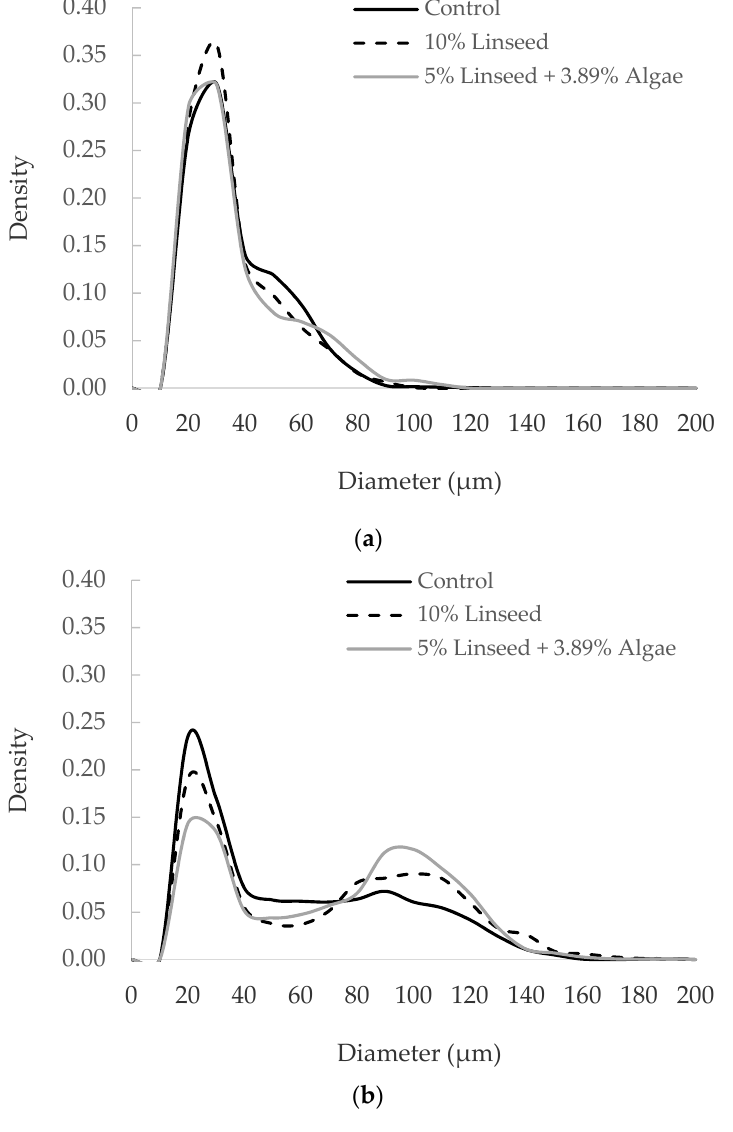
Figure 5. Effect of addition of linseed or linseed and algae to the diet on the adipocyte size distribution of lambs. Data reanalyzed from Urrutia et al. [71] (see Supplementary Material 1–3). ( a ) Analysis of intramuscular adipocyte size distribution of Navarra breed lambs; ( b ) analysis of subcutaneous adipocyte size distribution of Navarra breed lambs.